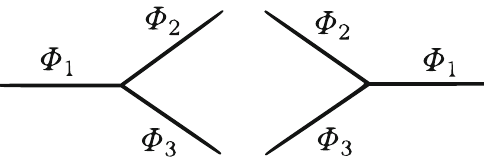
4 Emergence of interuniversal entanglement via decay process. Bell states and the entropy of